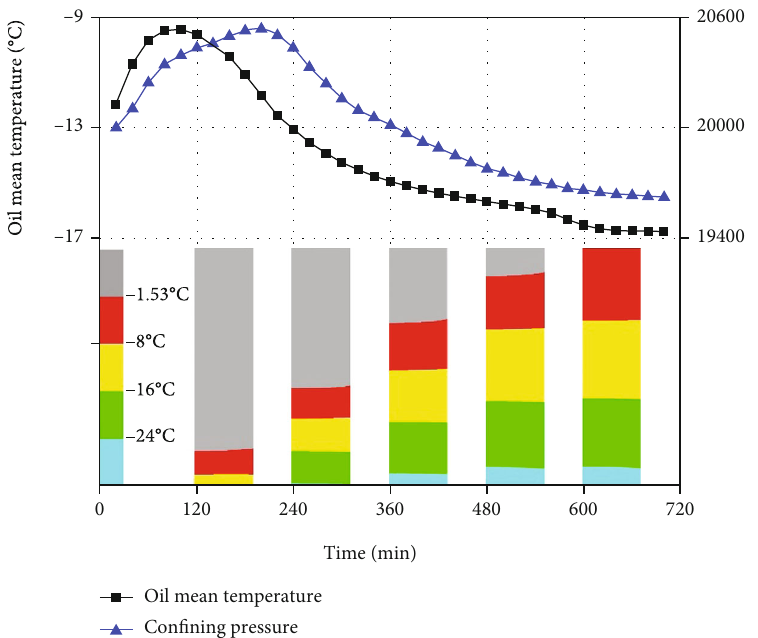
Figure 16: Changes in the simulated freezing state of the sample, the simulated mean temperature of the con fi ning medium, and the measured con fi ning pressure over time under the conditions that the sample was frozen in bottom-up direction but the change in the oil temperature was neglected. The freezing state of the sample is shown through an axisymmetric plane, and the time corresponds to the symmetry axis (left border of the